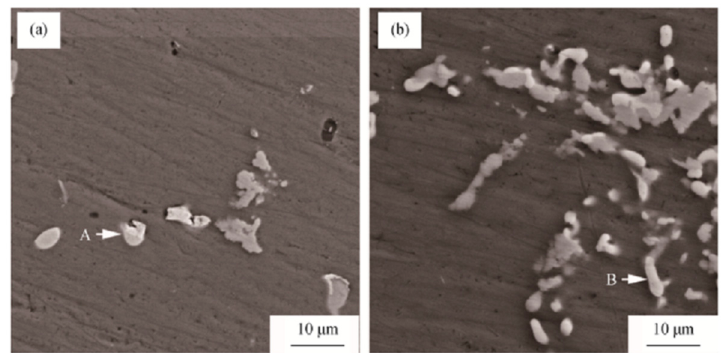
Figure 19. SEM images of homogenized ingots: ( a ) 7055; ( b ) 7055-0.25Sc. Adapted with permission from ref. [87]. 2019 Liu et al.